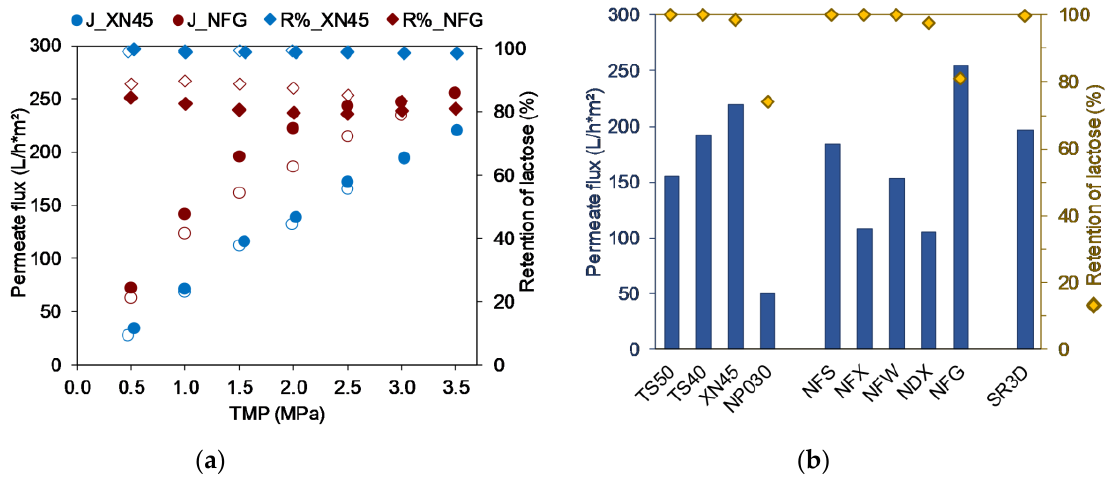
Figure 3. ( a ) Impact of varying transmembrane pressure (TMP) on permeate flux (J) and retention (R%) of lactose (filled icons: stepwise increase of the TMP, empty icons: stepwise reduction of the TMP); ( b ) Comparison of the membrane performance based on permeate flux (bars) and retention of lactose (squares) at transmembrane pressure of 3.5 MPa. Operation parameters in Table 3.